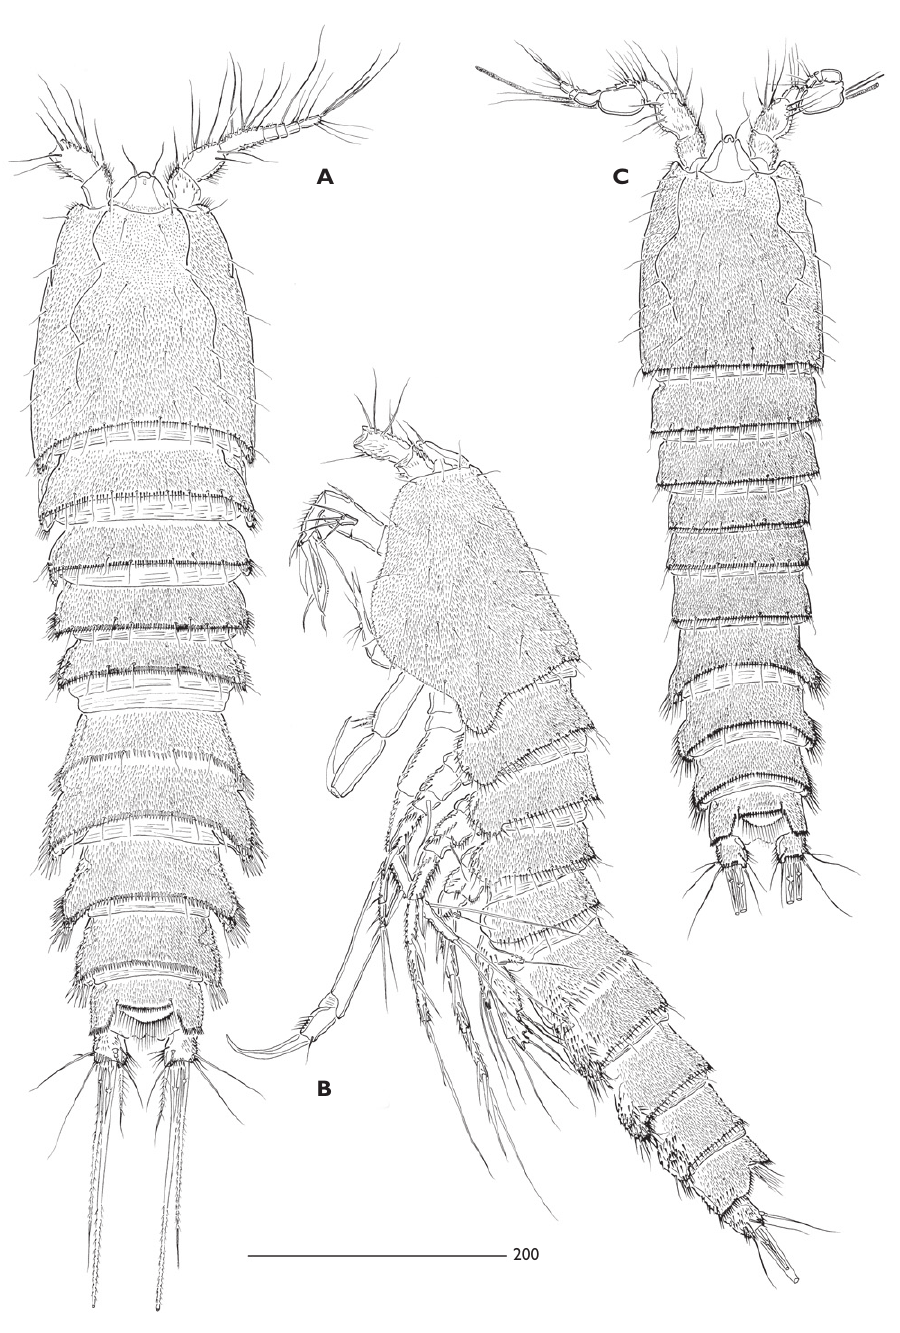
Figure 1. Marbefi a carthyi (Hamond, 1968), comb. n.: A habitus ♀ , dorsal B habitus ♀ , lateral C habitus ♂ ,